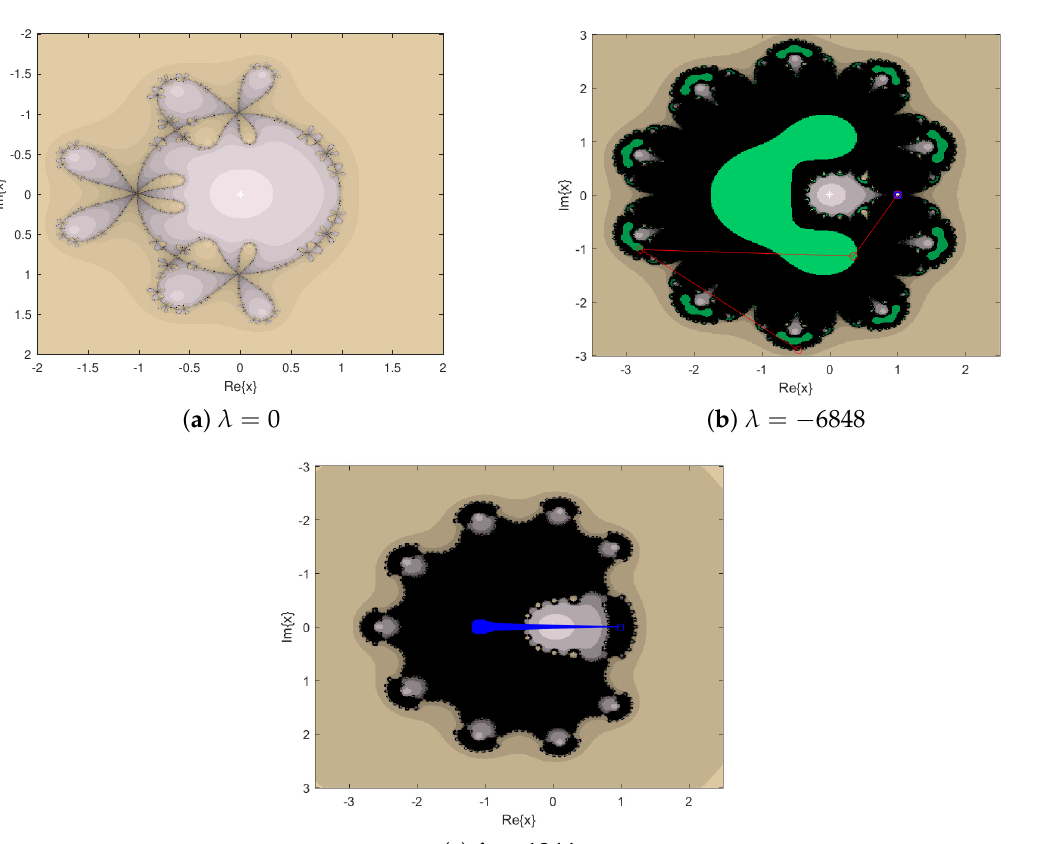
Figure 7. Dynamical planes for special λ